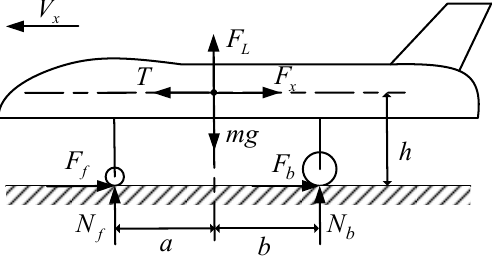
Figure 2. Force analysis of UAV.